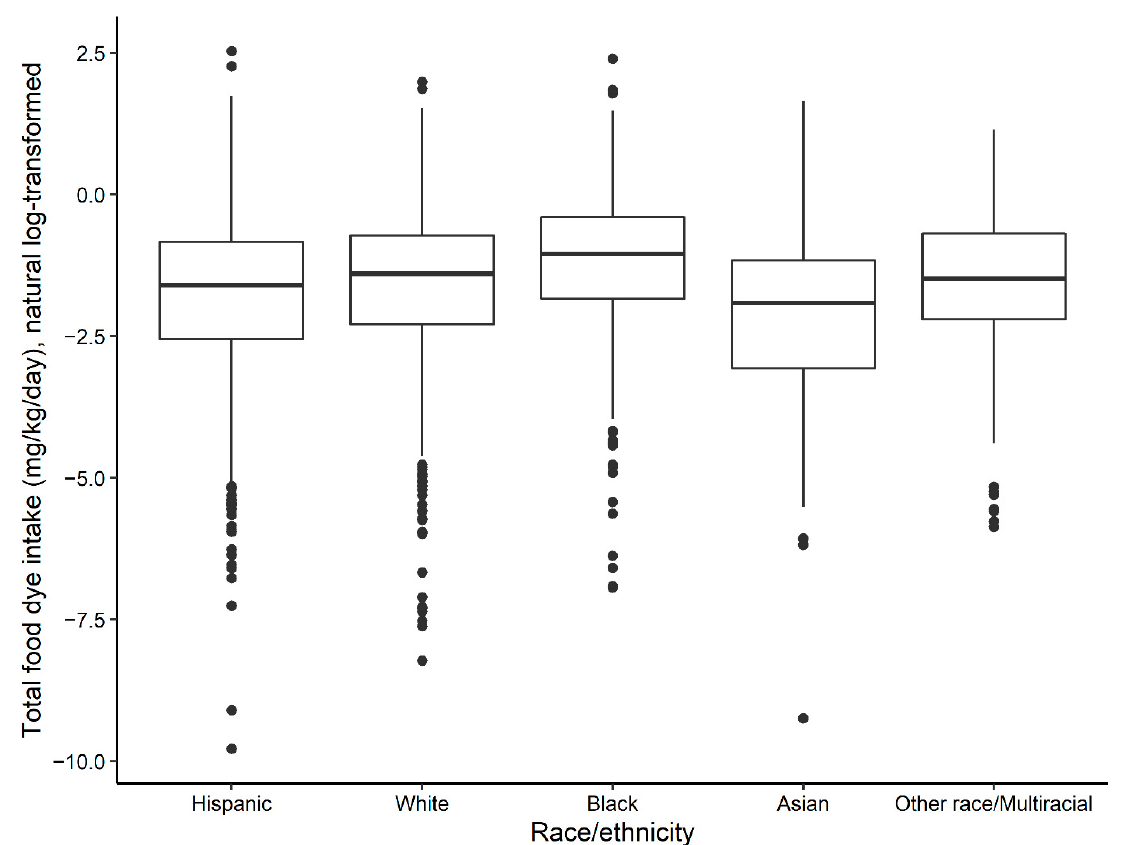
Figure 3. Total two-day average food dye intake estimates (natural log-transformed mg/kg/day) for children (0–18 years) by ethnicity (n = 2203).